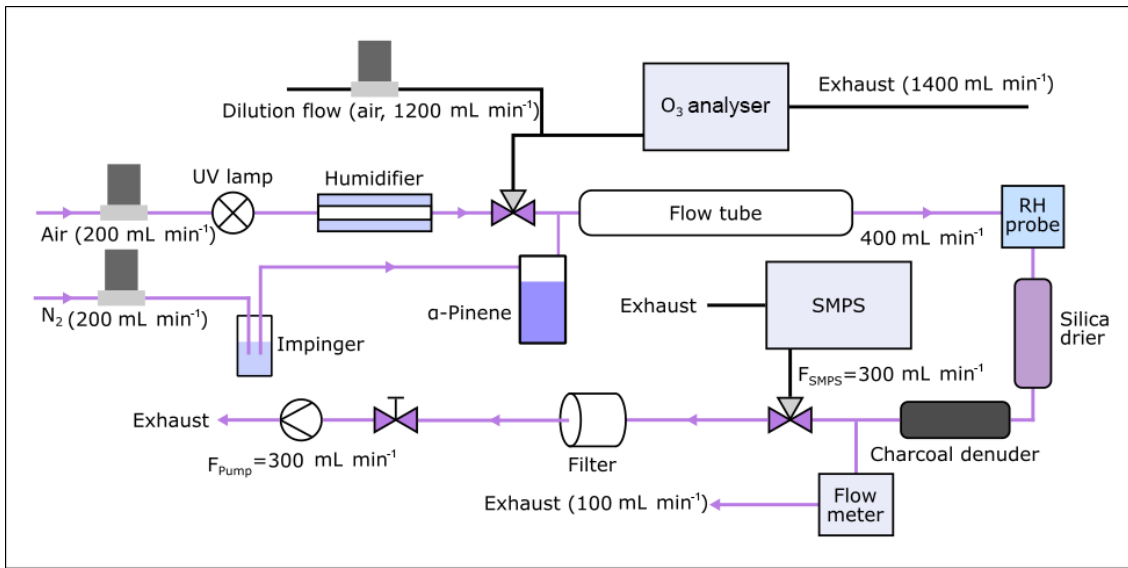
Figure 2. Flow tube set-up for oxidation under humid conditions. The pink lines show the gas and aerosol flow path during sample collection, when O 3 analyser and SMPS are not